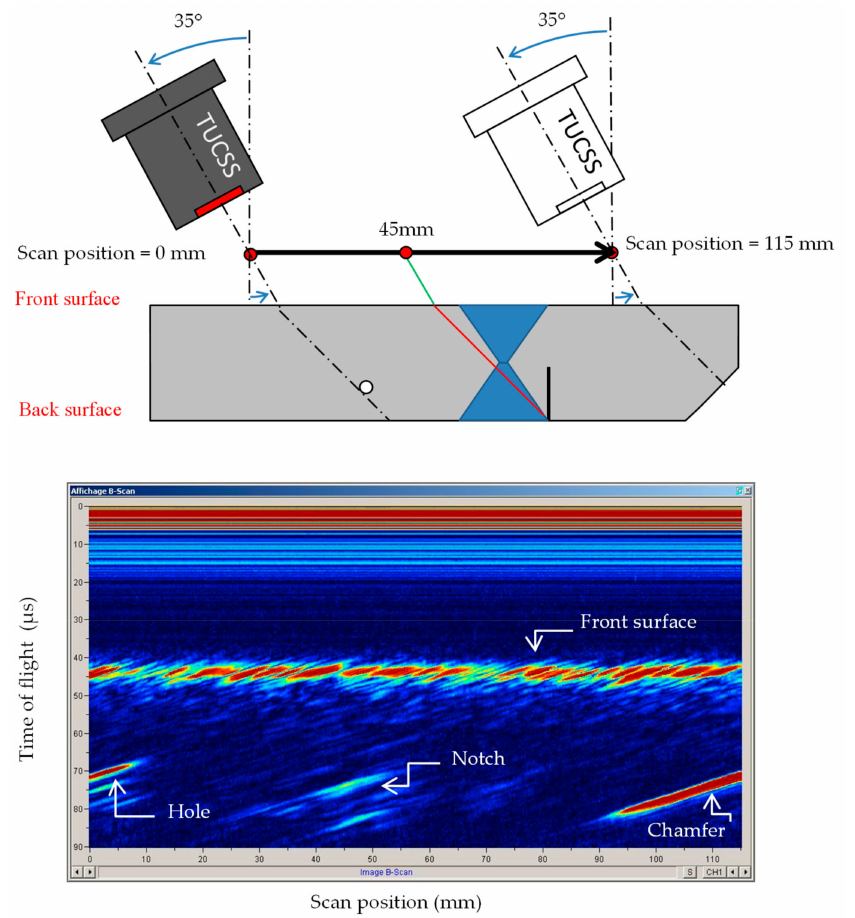
Figure 7. Scan at an incidence of 35 ◦ , generating 45 ◦ shear waves in the